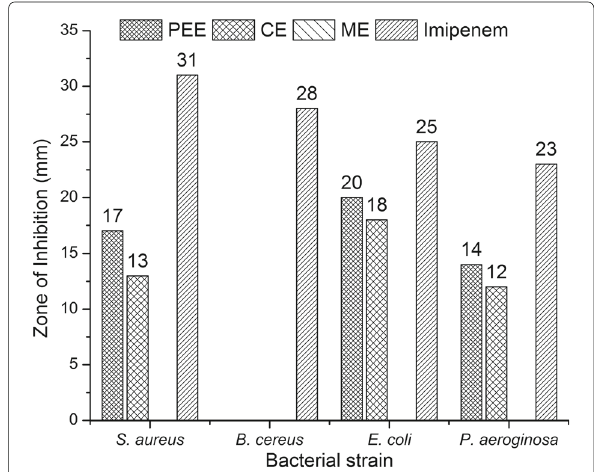
Fig. 6 Zone of inhibition of the C.pallida stem extracts against four bacterial strains. All tests were done two times. PEE-Petroleum ether extract, CE-Chloroform extract, ME-Methanol